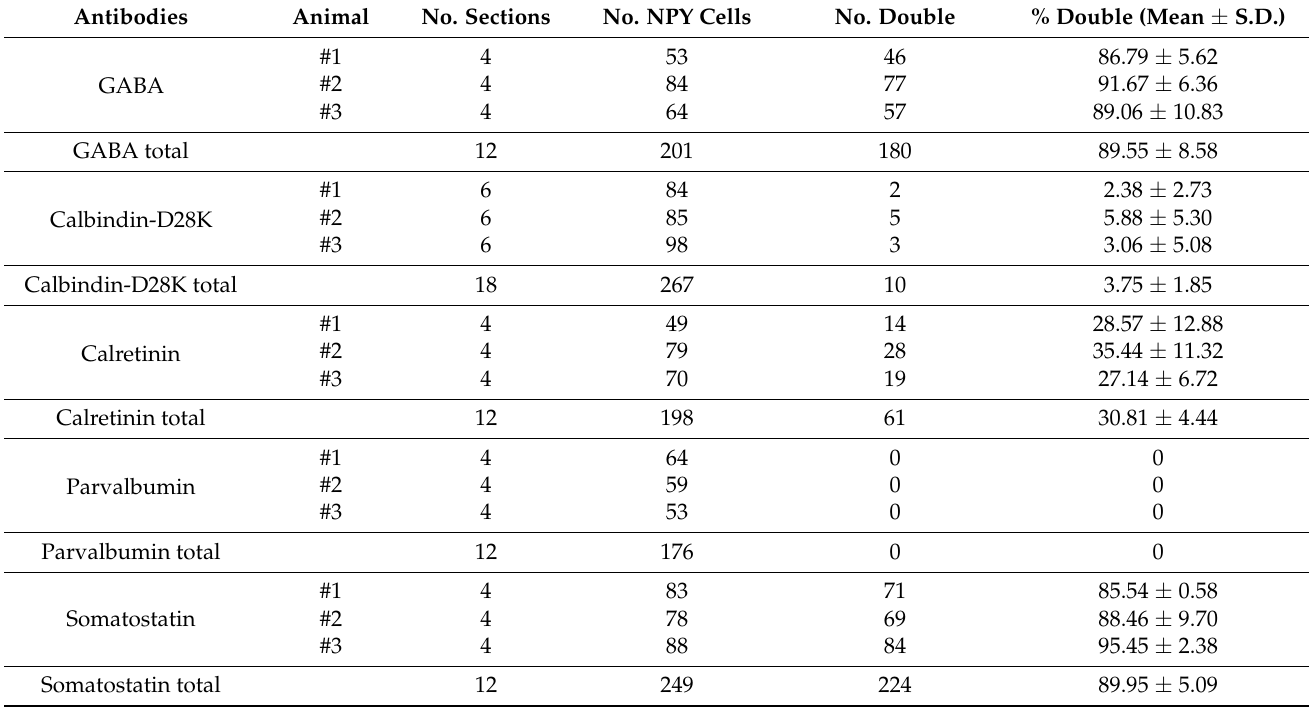
Table 1. Percentage of NPY-IR neurons, and neurons double-labeled with GABA, CBPs, or somatostatin in the gerbil visual cortex.